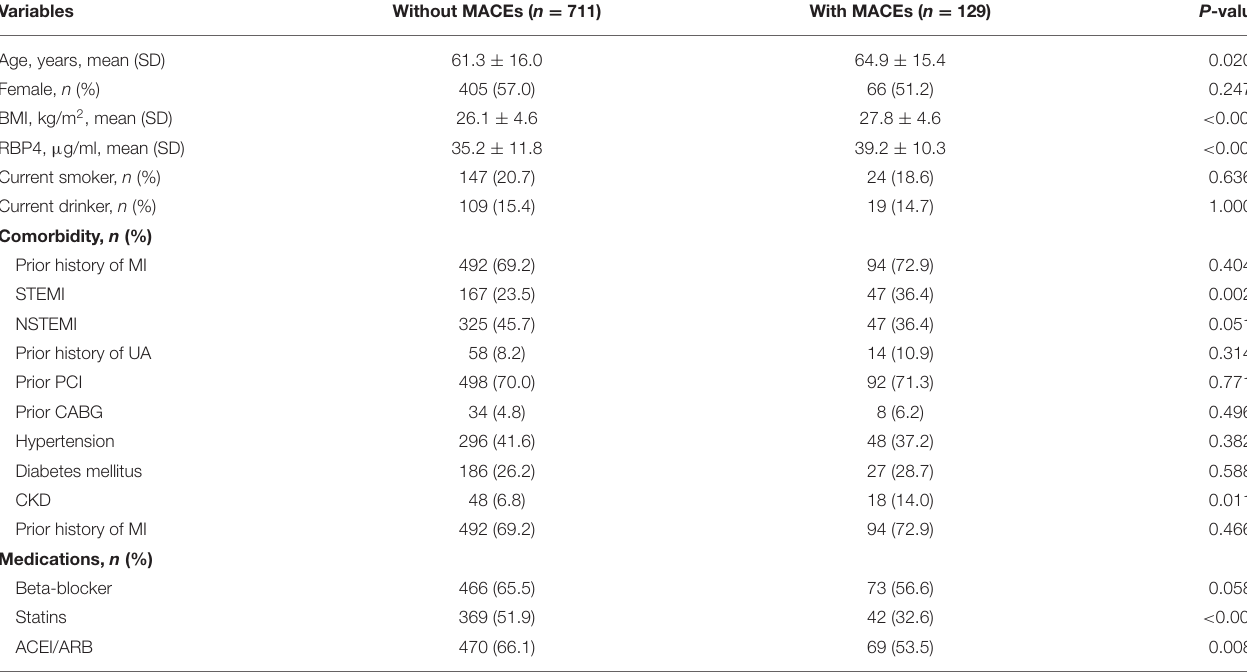
TABLE 2 | Differences in baseline characteristics between patients with and without MACEs. Variables